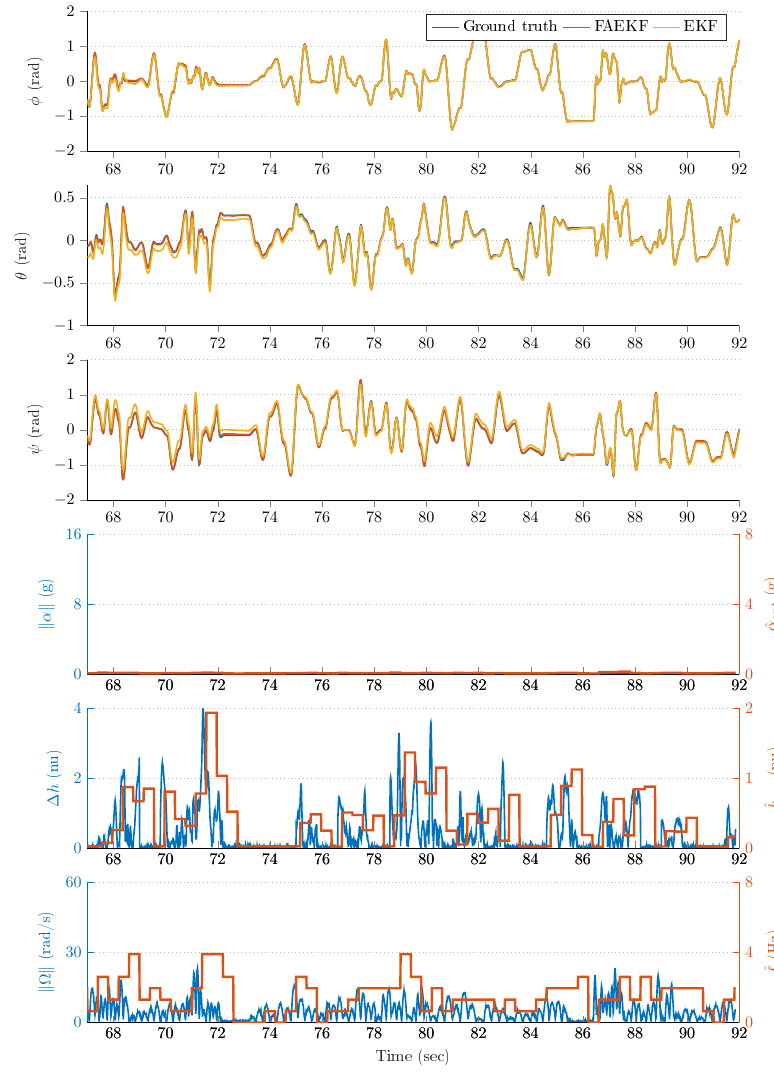
Figure 10. Third time slot from the